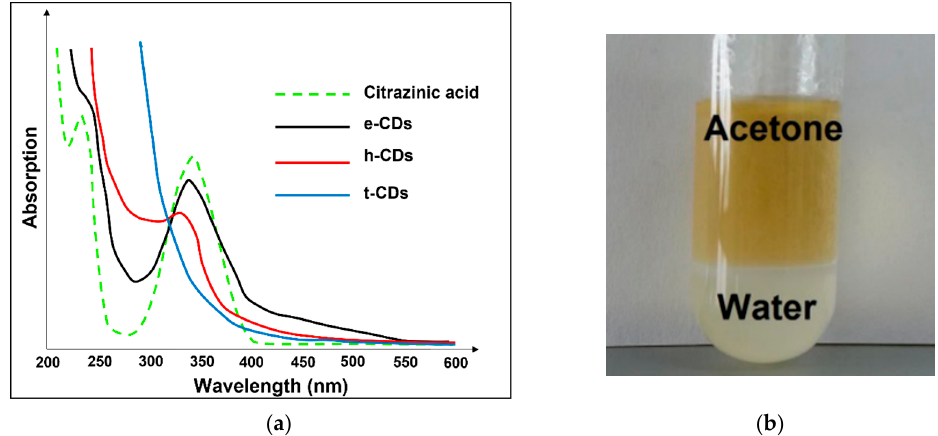
Figure 4. ( a ) Absorption spectra of three CD species and pure citrazinic acid. Adapted with permis- sion from ref. [130]. Copyright 2017 American Chemical Society; ( b ) the salt-induced phase separation using acetone. Reproduced with copyright permission of Elsevier [137].